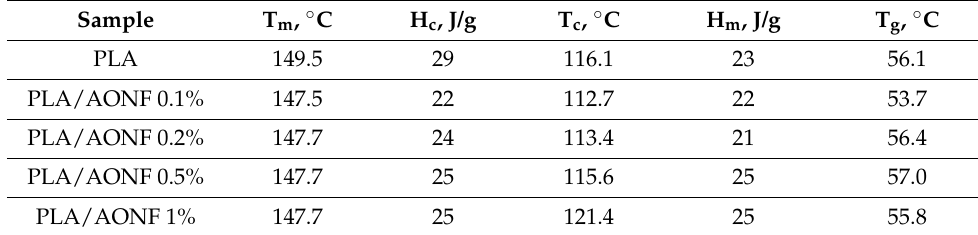
Table 1. Thermal properties of stock material (PLA) and PLA/AONF composite films.